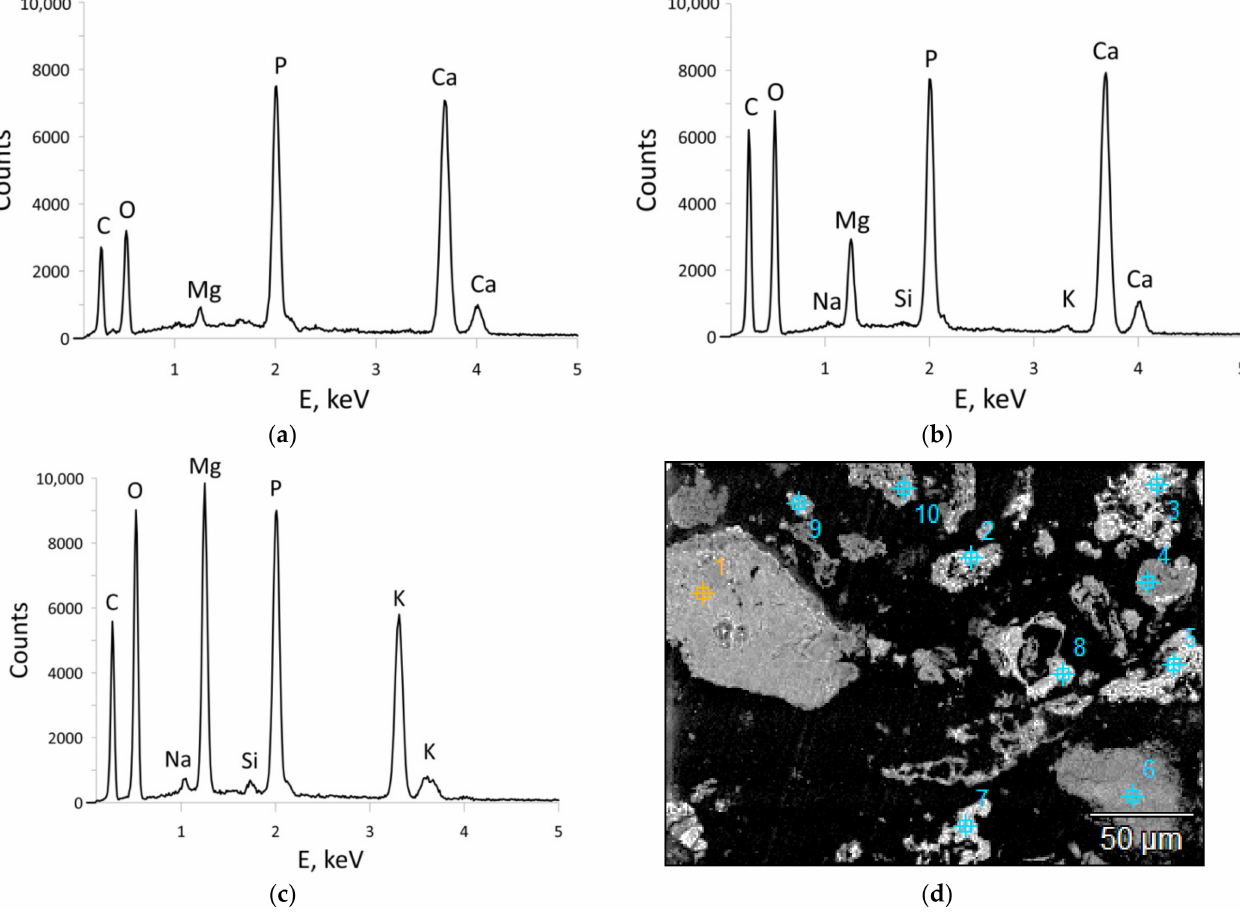
Figure 3. EDS spectra of the substance found in selected ash grains (sample PMA): ( a ) Ca-P substance; ( b ) Ca-Mg-P substance; ( c ) Mg-K-P substance; ( d ) view of analysed